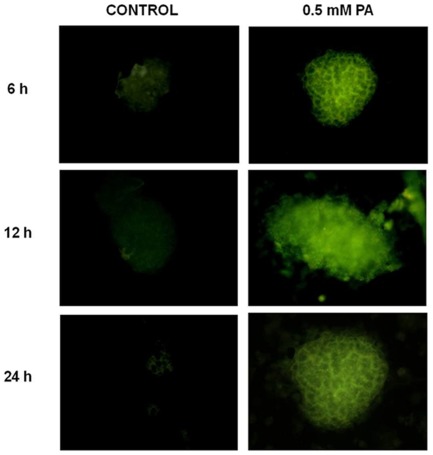
Mono-dansyl-cadaverine (MDC) fluorescence in isolated rat islets exposed for 6, 12 and 24 h to 0.5 mM PA.Isolated islets, previously loaded with the fluorescent probe, were deposited on microscope slides by centrifugation with a cytocentrifuge, as further detailed in Materials and Methods.